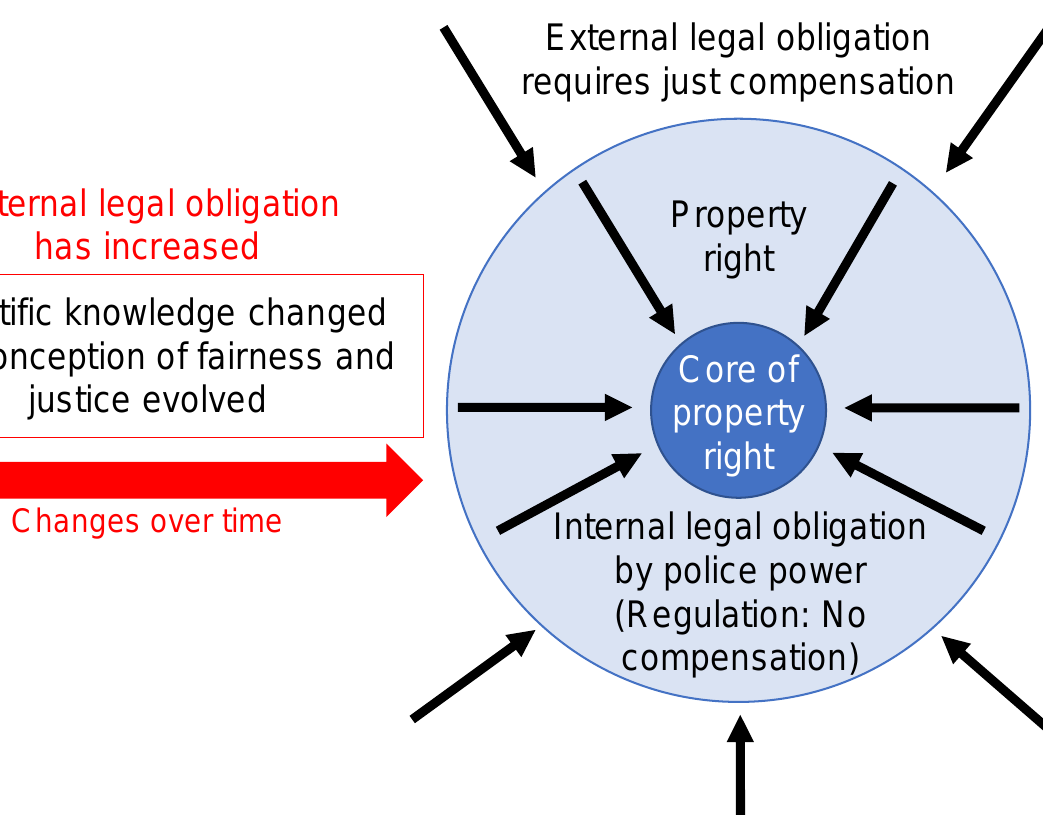
Figure 2. Internal and external legal obligations observed in